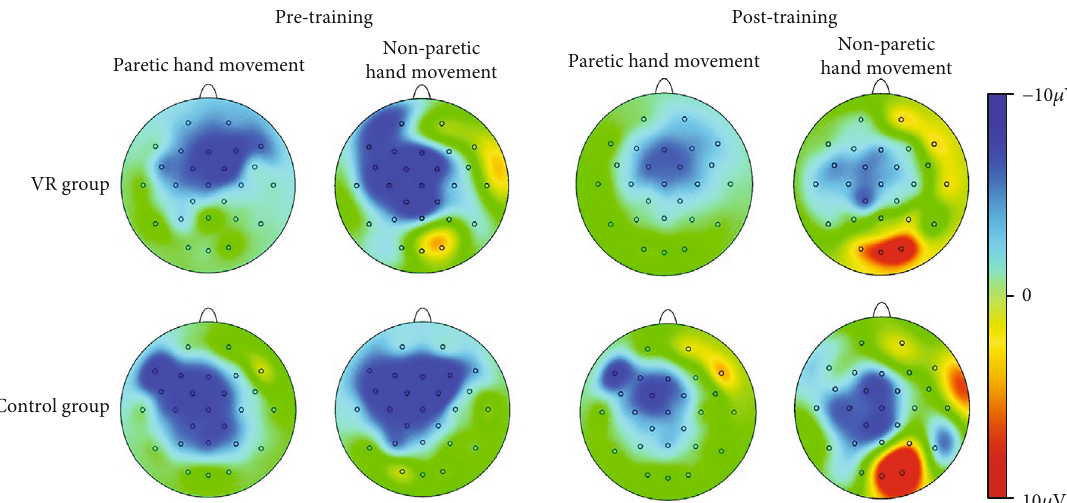
Figure 5: Topographic maps of participants in the two groups when executing paretic and nonparetic hand movement tasks.